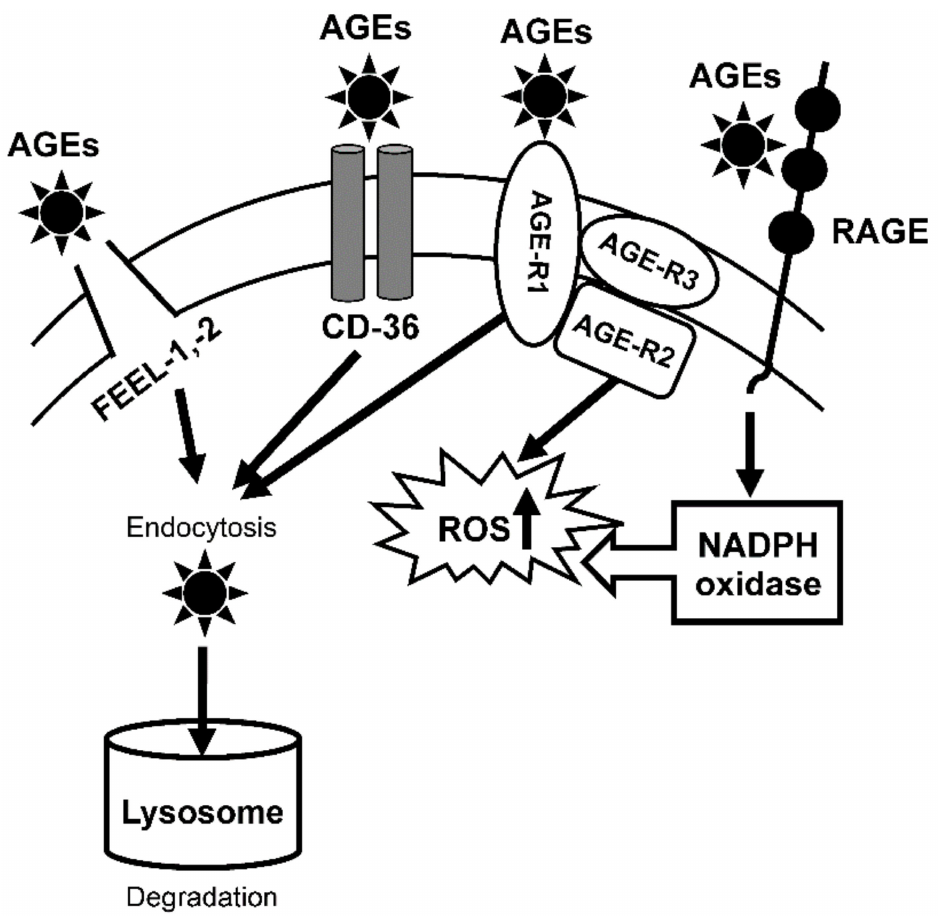
Figure 1. AGE receptors expressed in NHDF and their roles in intracellular events under stress conditions. Among AGE receptors AGE-R1, FEEL-1, FEEL-2, and CD-36 contribute to the endocy- tosis of extracellular AGEs into cells and their degradation through phagosome-lysosome fusion. Other AGE receptors, such as AGE-R2, AGE-R3, and RAGE, increase intracellular ROS generation directly or indirectly through the activation of NADPH